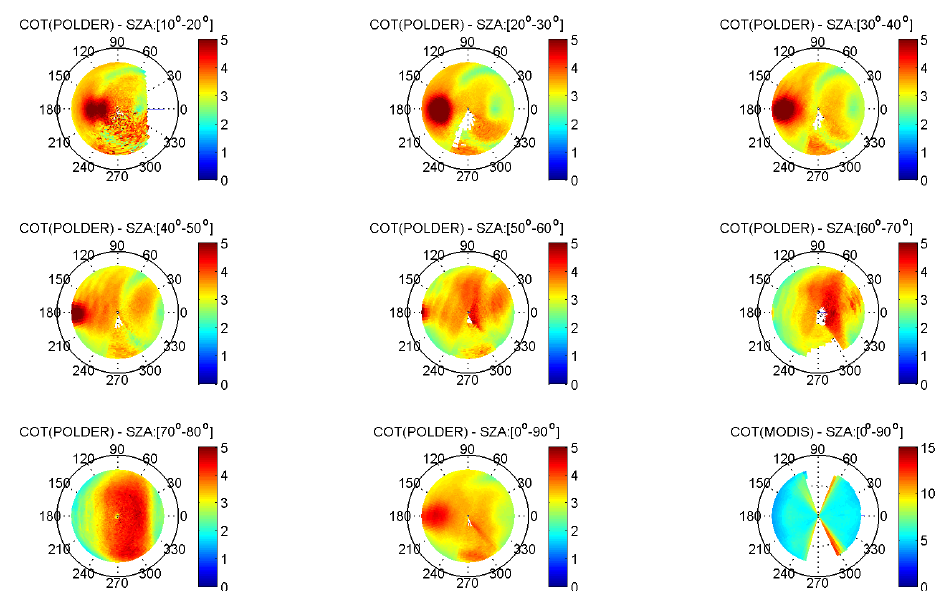
Fig. 9. Polar graphs of POLDER COT for broken oceanic liquid clouds for different solar zenith angles (1st, 2nd lines and the 1st column of the 3rd lines) and of MODIS COT for all sun angles (lower right corner). Polar angle represents relative azimuth angle between the satellite and the sun (from 0 ◦ corresponding to backscattering direction to 359 ◦ ). Polar radius corresponds to the sinus of the satellite zenith angle (from sin 0 ◦ = 0 to sin 90 ◦ = 1). Colors encode the averaged COT values for a given set of geometries. SZA means solar zenith angle range. There is a poor satellite sampling for relative azimuth angles between 240–300 ◦ for POLDER and between 60–120 ◦ and 240–300 ◦ for